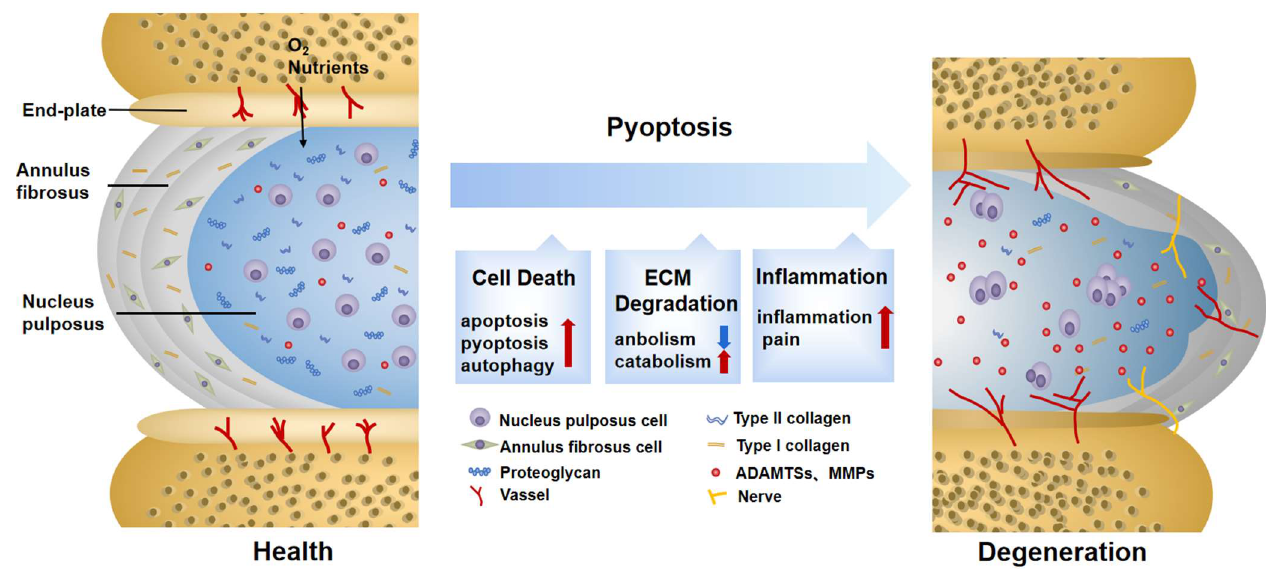
Figure 2. Changes in normal and degenerative intervertebral discs. The intervertebral disc is com- posed of nucleus pulposus (NP), annulus fibrosus (AF), and endplate (EP), together constituting a closed buffer system against stress. While in IDD, cell death, ECM degradation, and secondary ver- ification aggravate the vicious cycle, which is closely associated with pyroptosis. ECM: extracellular matrix; ADAMTS: a disintegrin and metalloproteinase with thrombospondin motifs; MMPs: matrix metalloproteinases.